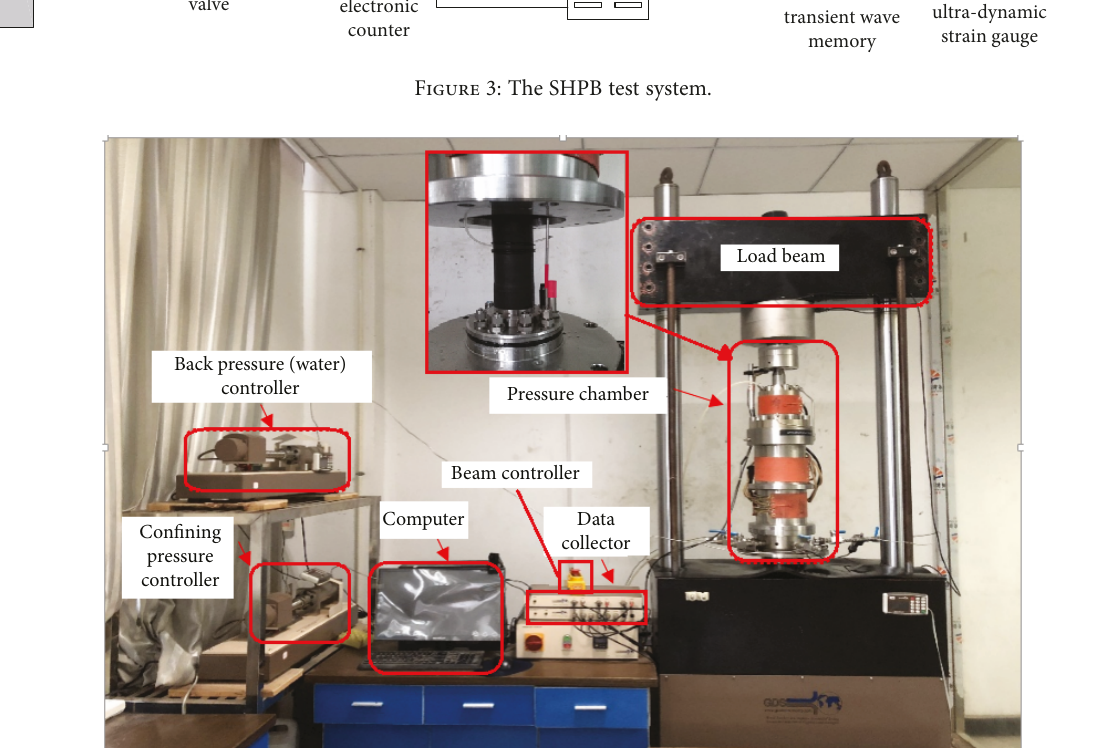
Figure 4: GDS-VIS triaxial